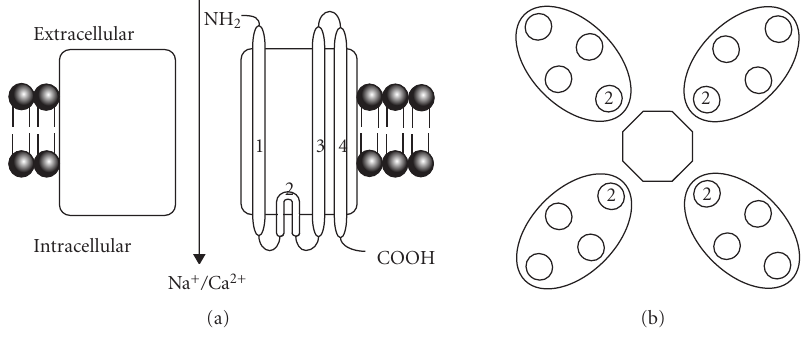
Figure 2: Schematic representation of ionotropic glutamate receptor structure. (a) Each subunit comprises 4 hydrophobic regions of which 1, 3, and 4 are transmembrane domains, while region 2 forms a reentrant loop at the intracellular surface. (b) Receptor subunit organization: the ion channels are formed from four subunits, which orientate allowing the second membrane domain to form the ion channel pore.